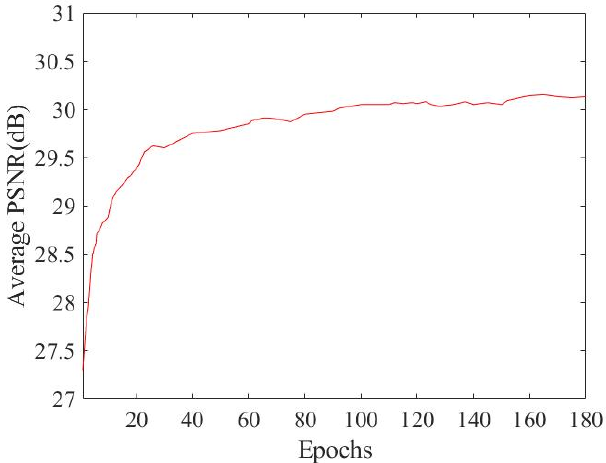
Figure 6. The relationship between the number of iterations Epoch and PSNR.